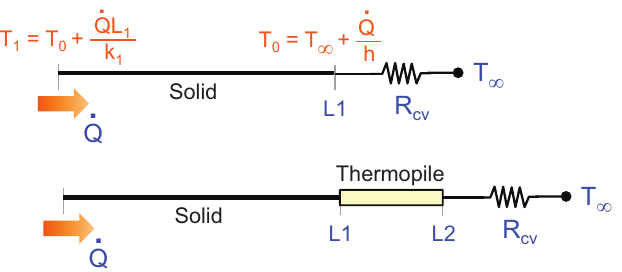
Figure 5. 1D simulated geometry. ( Top ) domain and initial temperature distribution when no thermopile is present. ( Bottom ) domain with thermopile